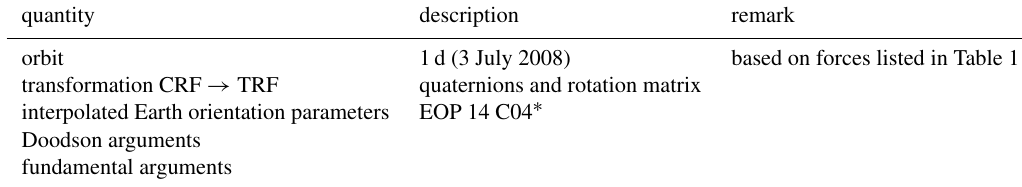
description remark